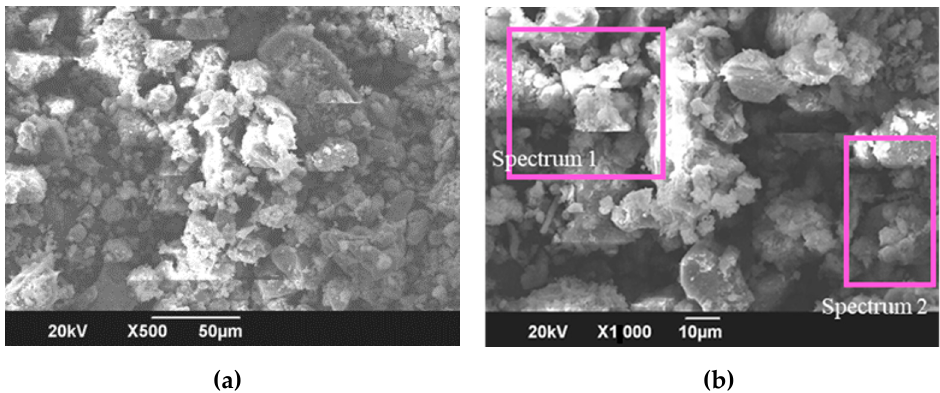
Figure 9. SEM pictures of the GC-5-0-1 sample at ( a ) 500× magnification and ( b ) 1000× magnifica- tion.